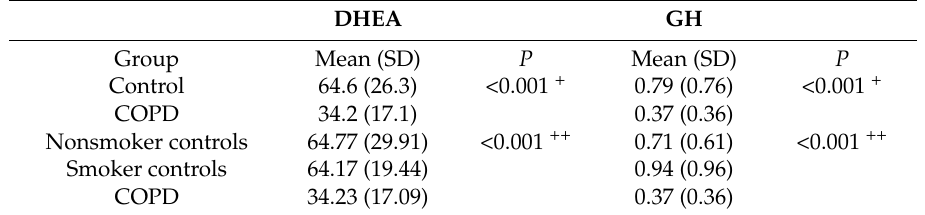
Table 2. Dehydroepiadrosterone(DHEA) and Growth Hormone (GH) levels in the study groups.